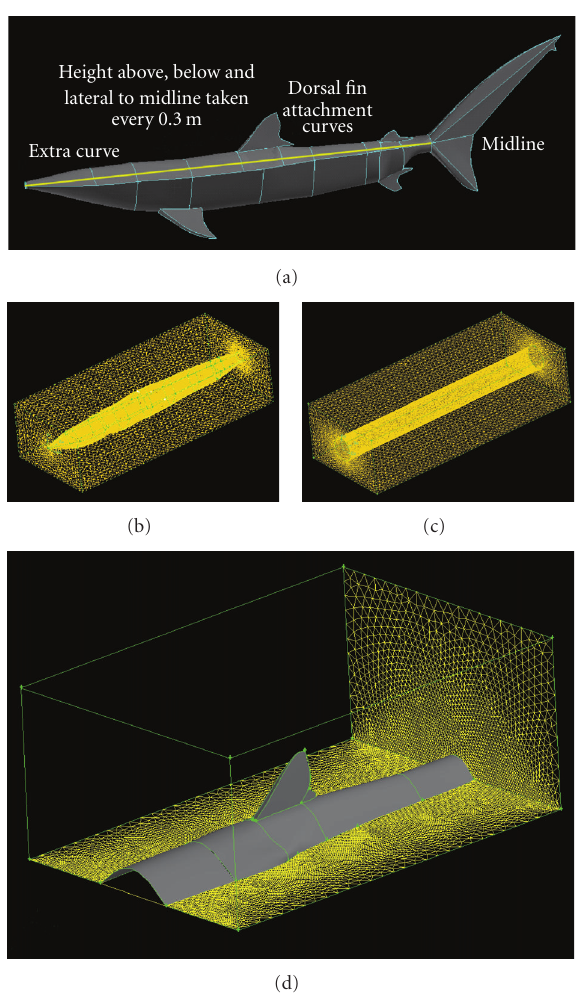
Figure 1: (a) Specimen A displayed in Gambit describing the measuring method used and all fin morphologies within the 3-dimensional Cartesian axis. Gambit meshed volumes of (b) specimen E (body section) and (c) specimen E (body section) control (cylinder e). (d) Dorsal fin section model (specimen E) displaying the cut away mesh regime of the flow tank walls and the shark dorsal section model with dorsal fin